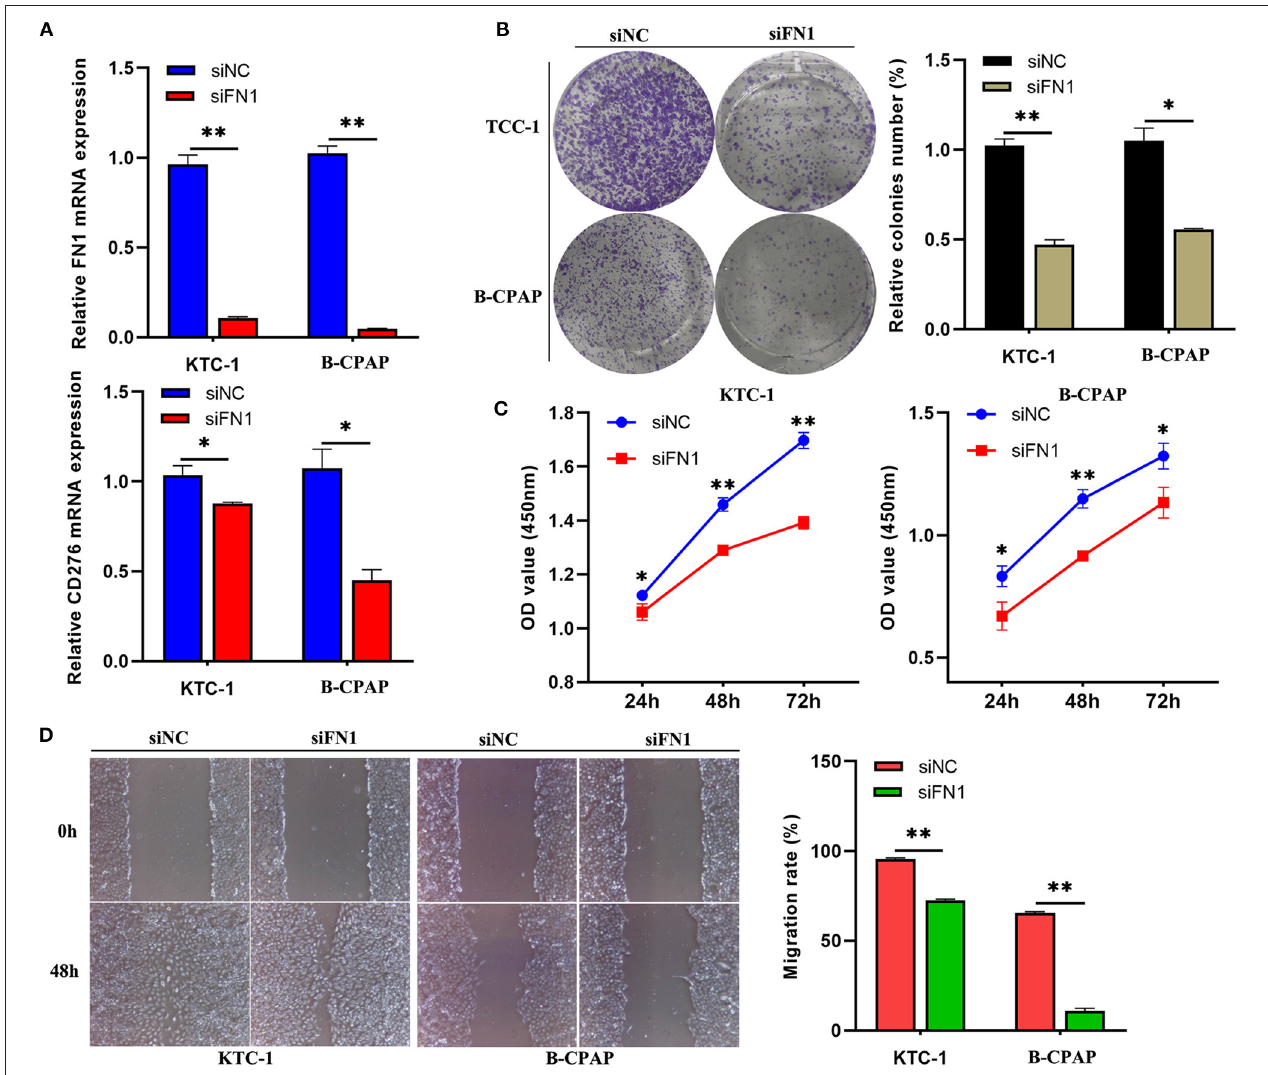
FIGURE 6 | Down-regulation of FN1 suppressed THCA cell migration and invasion in vitro . (A) qRT-PCR showing the efficient depletion of FN1 expression and the expression of CD276 in B-CPAP and KTC-1 cells compared with siNC transfection. Representative photo-images (left) and histograms (right) of the effect of siFN1 on the clone formation (B) and migration (D) of B-CPAP and KTC-1 cells. (C) The proliferative ability of B-CPAP and KTC-1 cells after transfection was evaluated by CCK-8 assay. * p < 0.05, ** p <